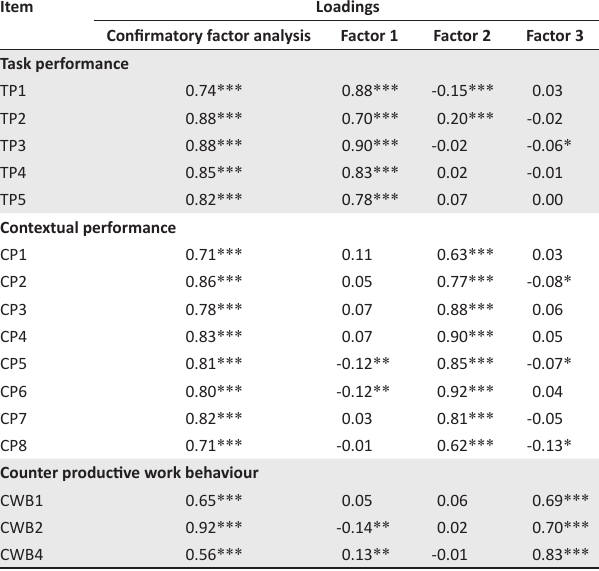
TABLE 2: Standardised factor loadings for independent and exploratory structural equation modelling. Item